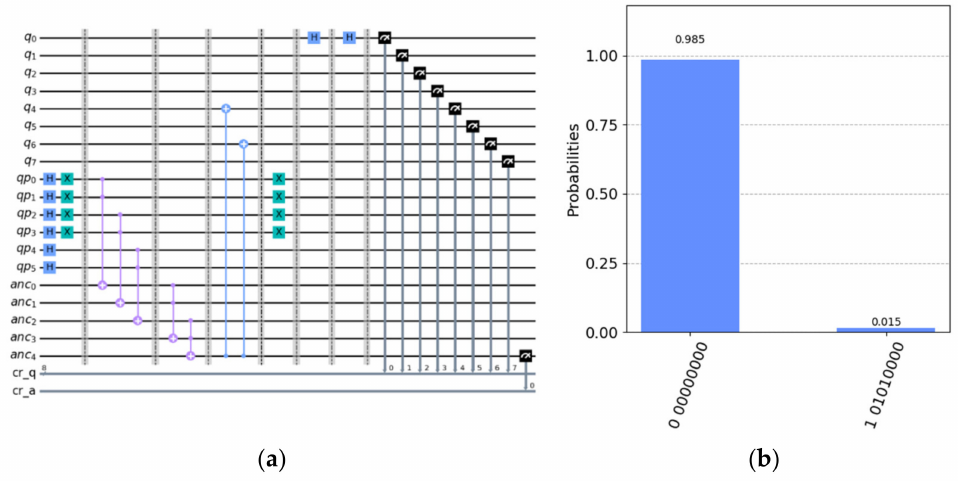
Figure 10. ( a ) The NEQR representation for the seventh pixel (gray level 80, LSB set to 0) and ( b ) the measurement